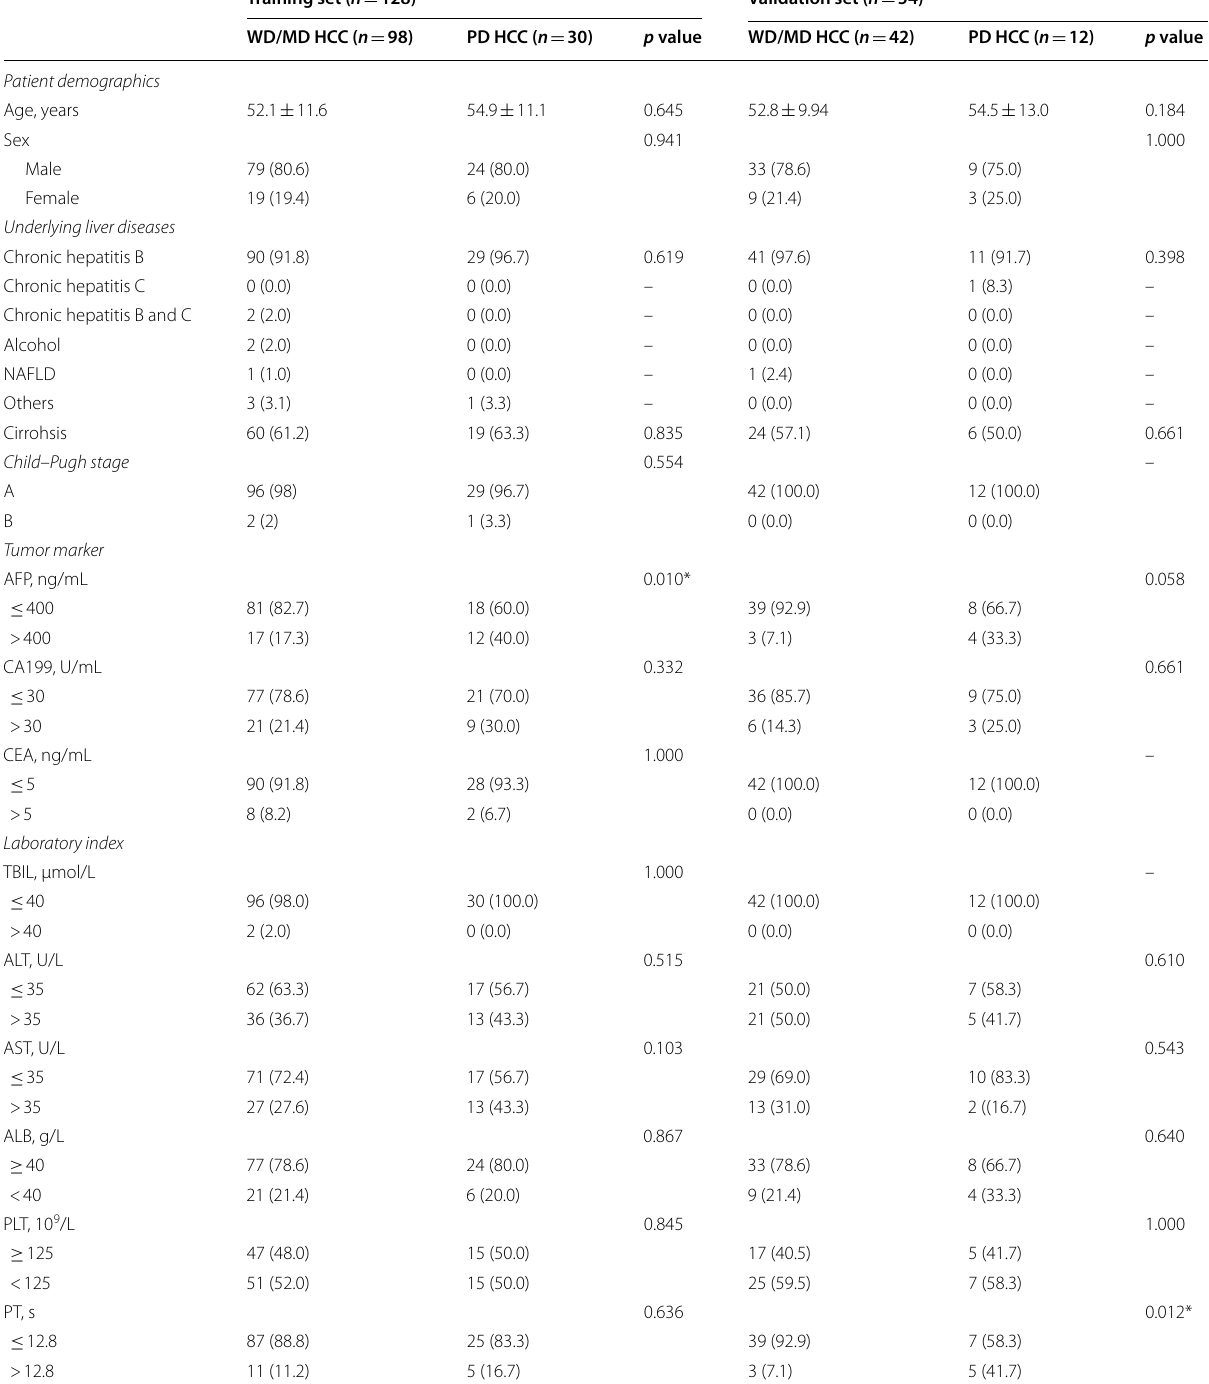
Table 1 Baseline clinical characteristics of